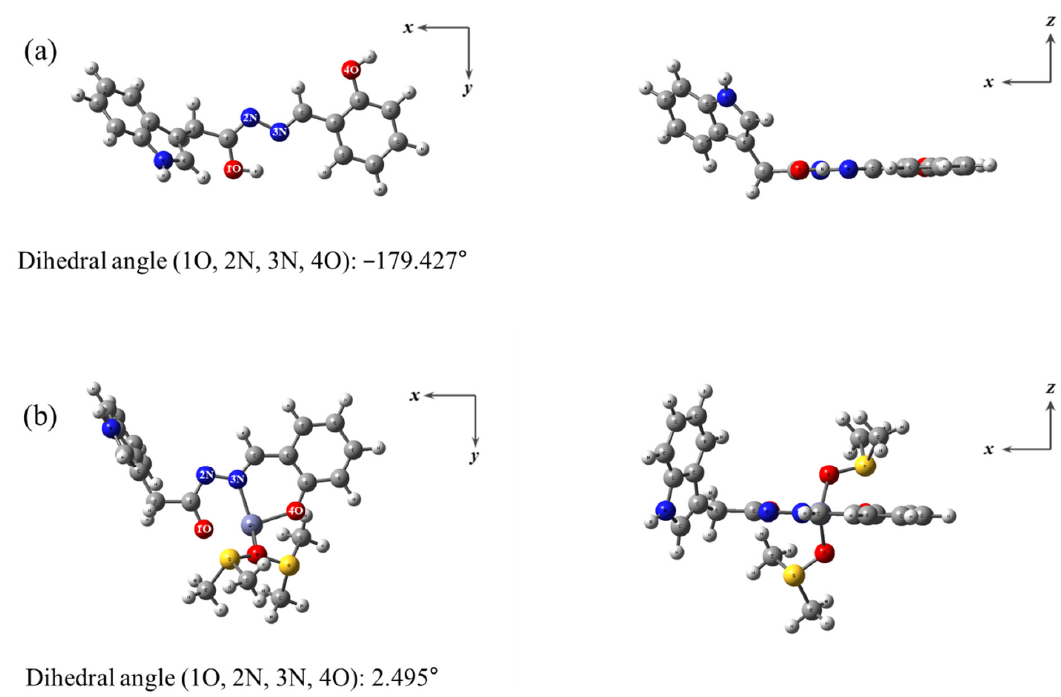
Figure 4. Energy-optimized patterns of ( a ) IH-Sal and ( b ) IH-Sal -Zn 2+ .